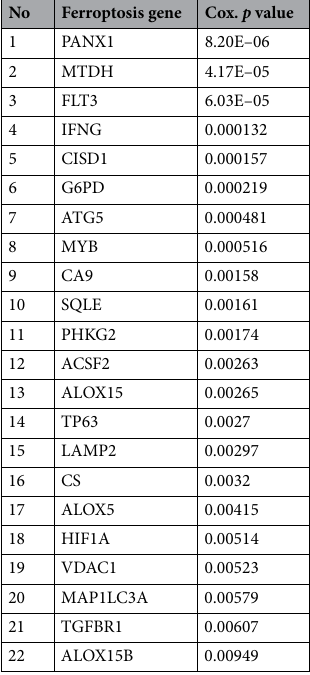
Table 3. Results of ferroptosis gene Cox regression